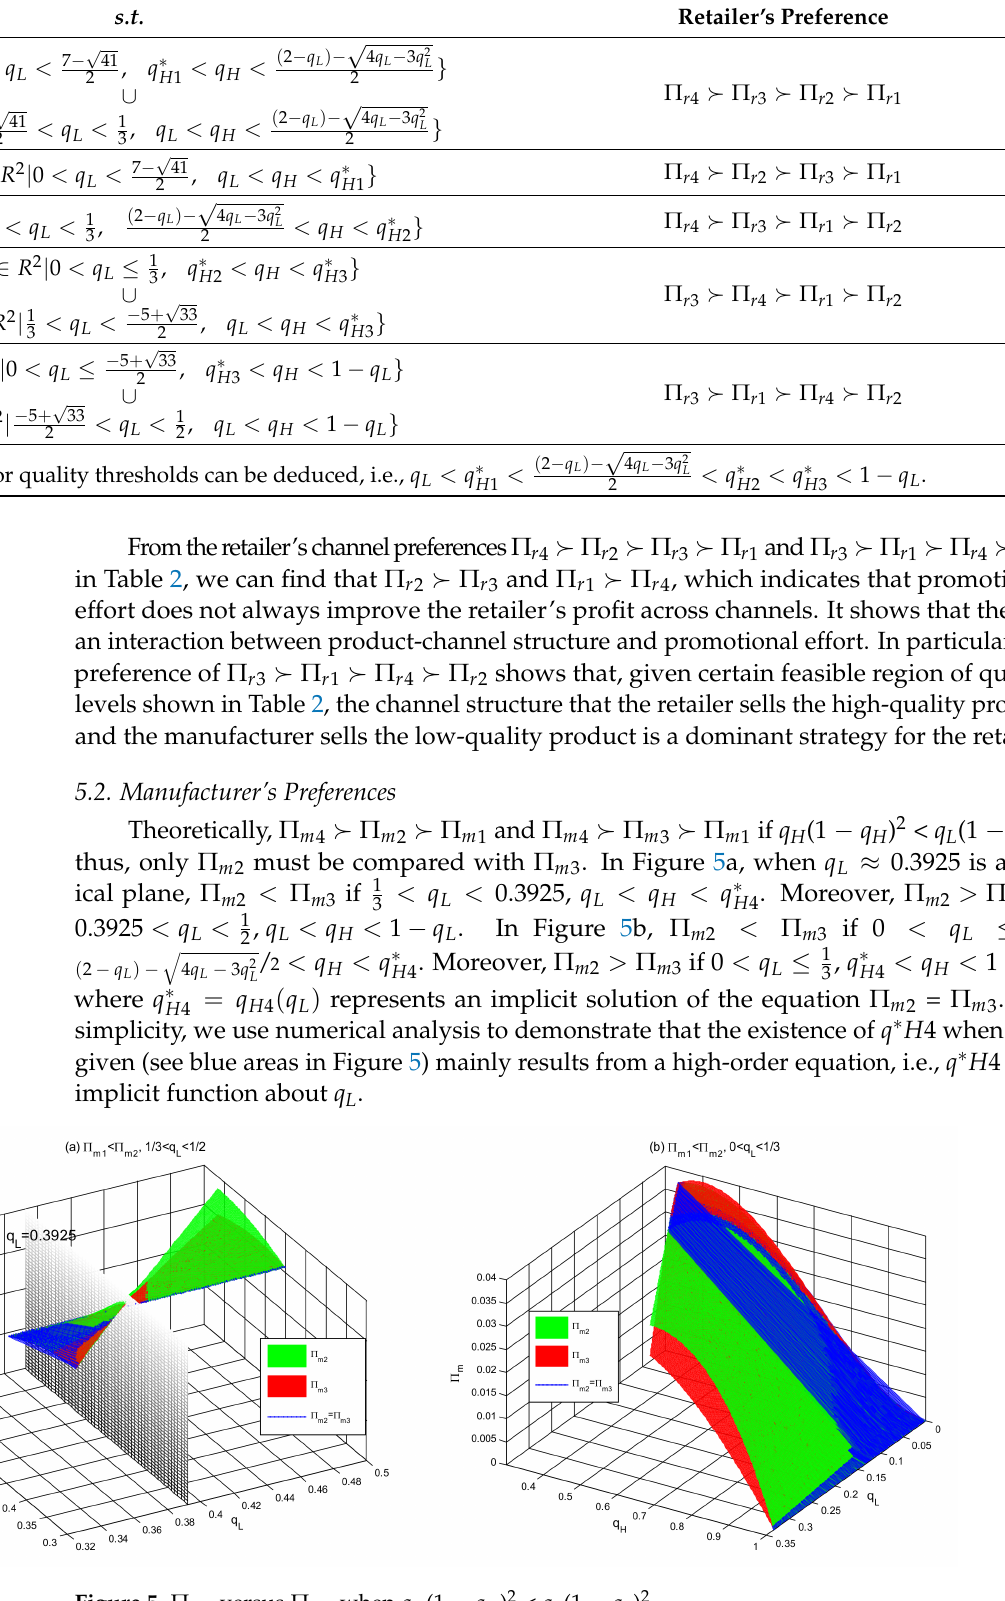
Figure 5. Π m 2 versus Π m 3 when q H (1 − q H ) 2 < q L (1 − q L ) 2